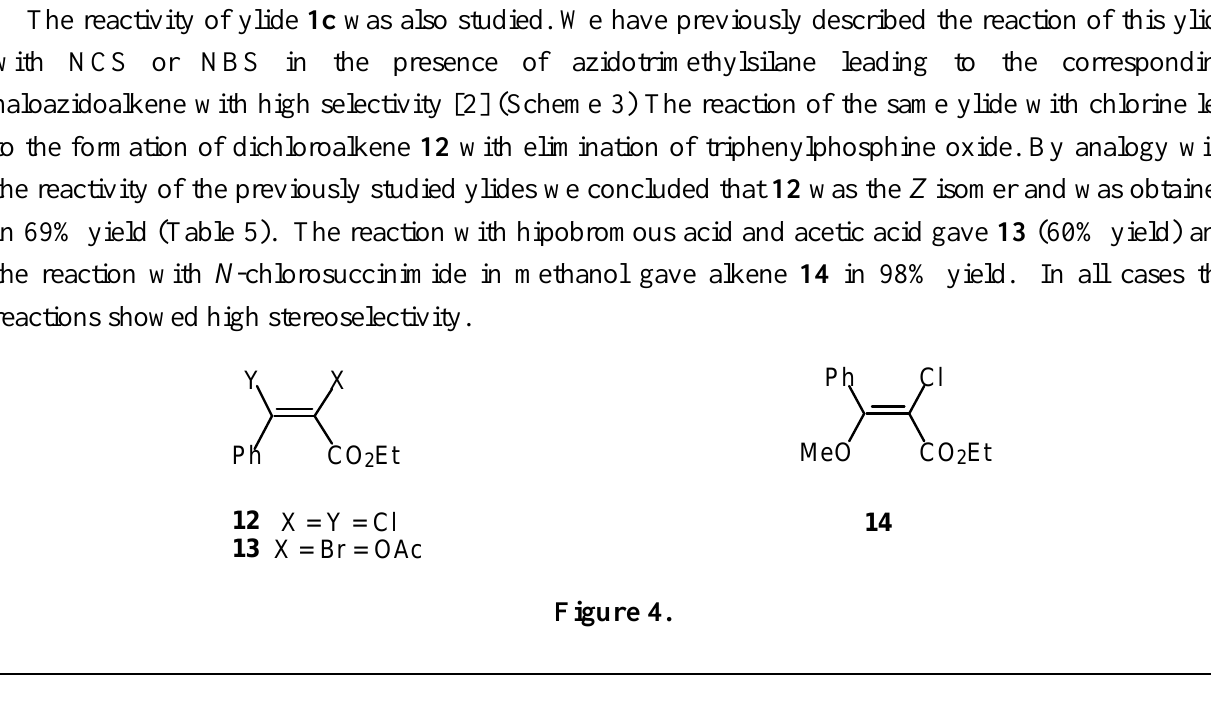
Table 5. Products obtained from the ylide 1c